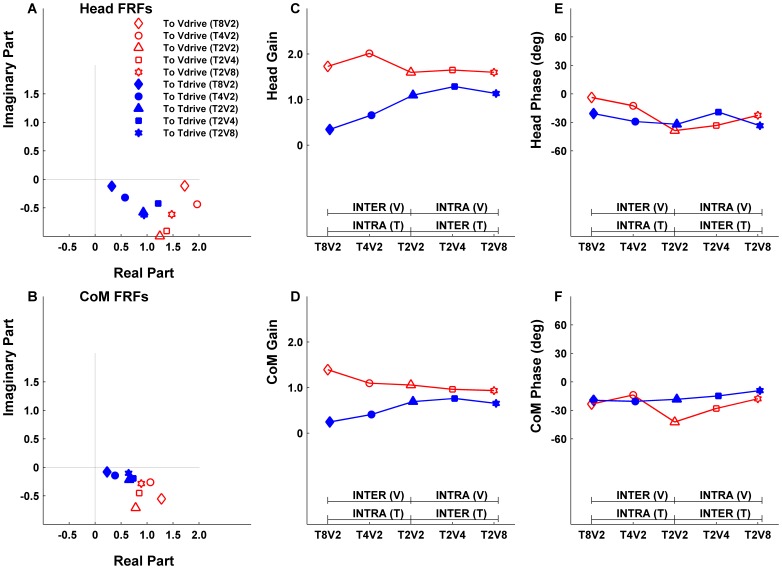
Exemplar of averaged frequency response functions (FRFs), gains and phases.Results are averaged across three trials for each condition from all five test conditions in a 7.6-year-old child with DCD. Subplots in the first column show the FRFs in the complex plane for the Head (A) and CoM (B). The distances from the FRFs to the origin are the gains and they are plotted in the middle column subplots for Head gains (C) and CoM gains (D) to Tdrive (filled markers) and Vdrive (open face markers). Intra-modal reweighting refers to gain changes due to the change of a specific modality’s amplitude. For example, symbol such as |- INTRA (T) -| indicates that touch gain intra-modal reweighting is evaluated across T8V2 and T2V2 conditions. Similarly, |- INTRA (V) -| indicates that vision gain intra-modal reweighting is evaluated across T2V2 and T2V8 conditions. Inter-modal reweighting refers to gain changes due to the change of a coexisting modality’s amplitude. For example, symbol |- INTER (T) -| indicates that touch gain inter-modal reweighting is evaluated across T2V2 and T2V8 conditions while |- INTER (V) -| indicates that vision gain inter-modal reweighting is evaluated across T2V2 and T8V2 conditions. A significant gain difference between conditions indicates reweighting. This child demonstrates intra-modal touch reweighting. The angle between the FRFs and the positive real axis are phases and they are plotted in the right column subplots for Head phase (E) and CoM phase (F). Note that phases are all negative indicating a phase lag of postural response to drives.